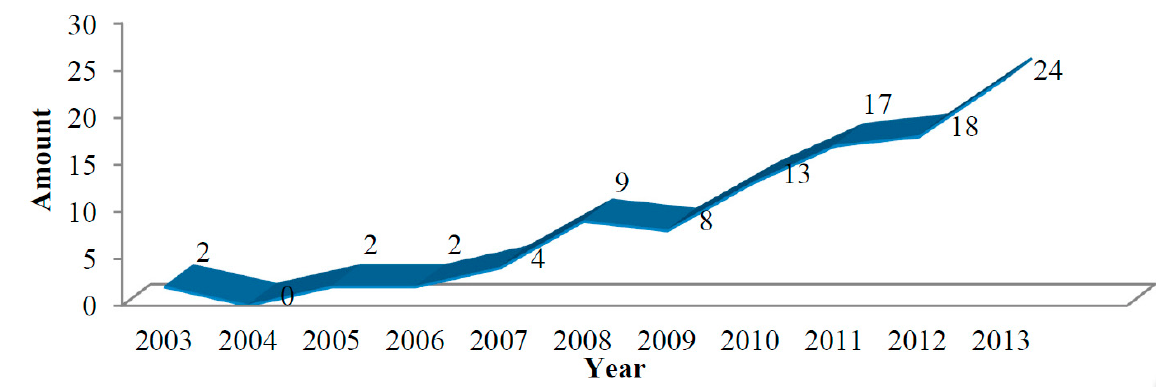
Figure 1. Line chart showing the total amount of research articles on the TCM spectrum-effect relationship approach published from 2003 to